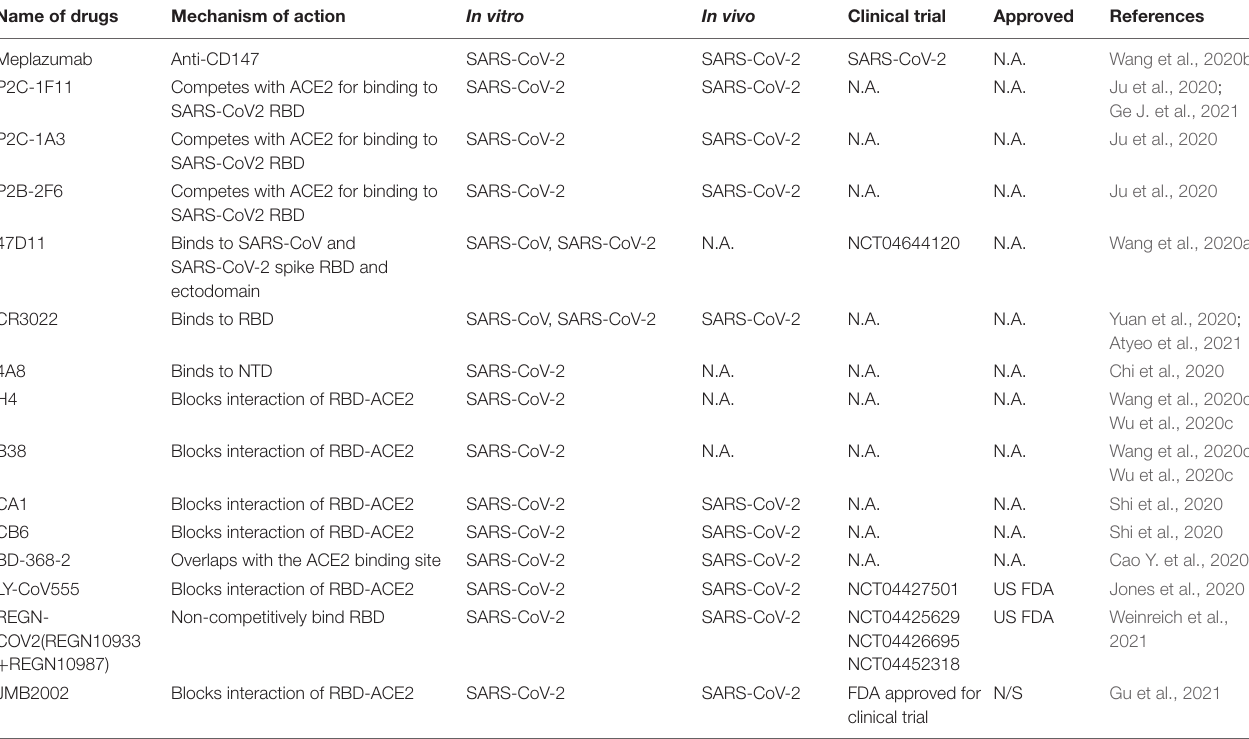
TABLE 4 | Representative therapeutic antibodies strategies for CoV infections. Name of drugs